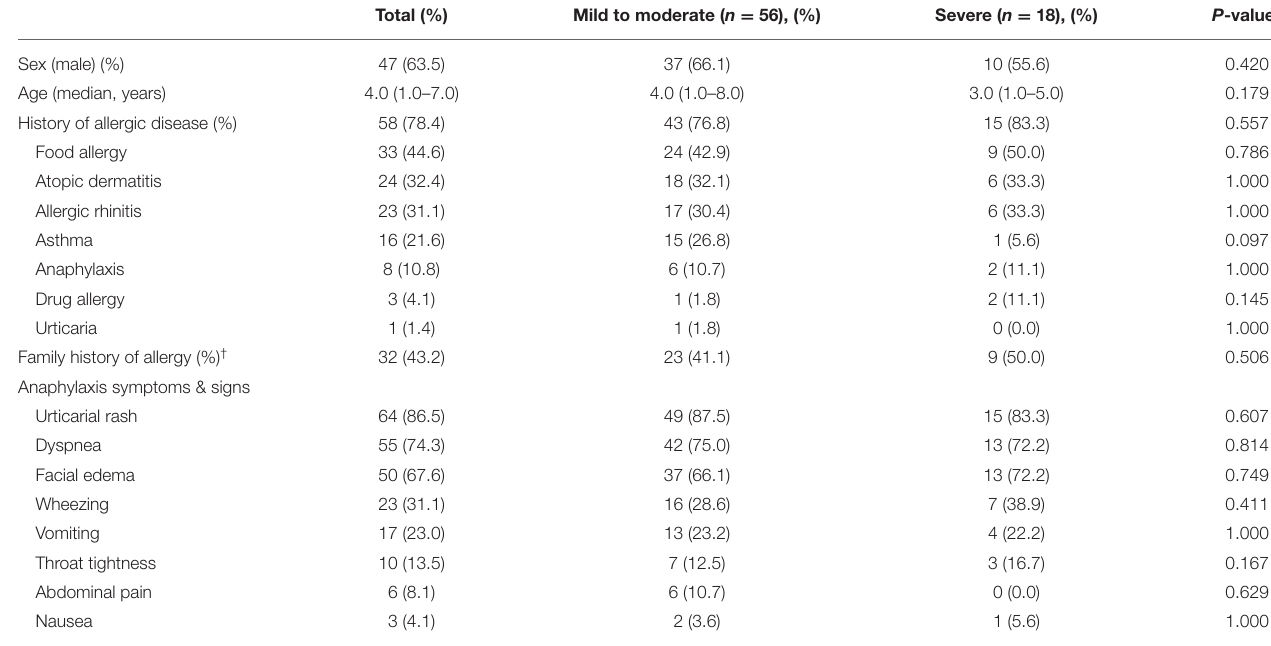
TABLE 1 | Clinical characteristics of the patients with anaphylaxis who underwent allergy tests ( n = 74) and a comparison of the severity of anaphylaxis (mild to moderate vs. severe). Total (%) Mild to moderate ( n = 56), (%) Severe ( n = 18), (%) P